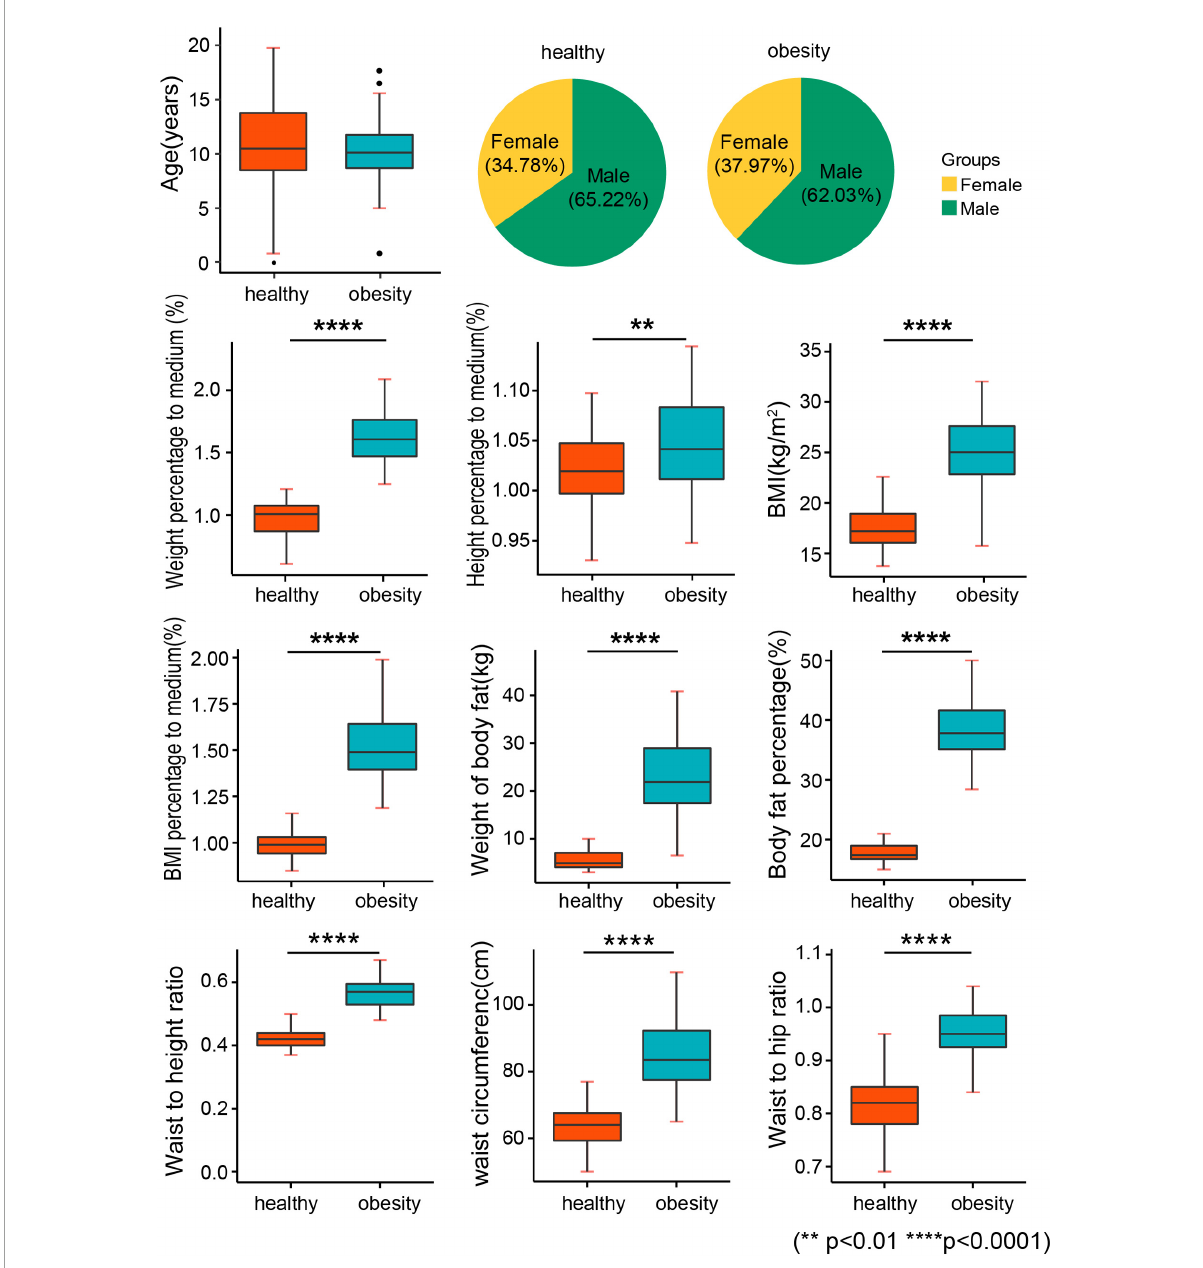
FIGURE1 Baseline characteristics. BMI, body mass index; weight percentage to medium: the percentage of body weight to the median of standard body weight; height percentage to medium: the percentage of height to the median of standard height; BMI percentage to medium: the percentage of BMI to the median of standard